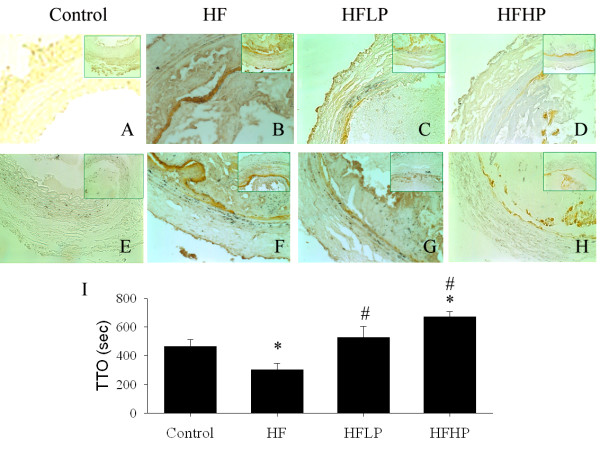
Effect of PHGG on 30% FeCl3-induced 4-HNE, ICAM-1 and TTO in the injuried carotid artery of the hamsters with HF diet. Oxidative stress indicated by 4-HNE (A-D) and ICAM-1 (E-H) immunostaining of hamster carotid arterial sections subjected to 150 sec of FeCl3-induced arterial injury. Significantly enhanced endothelial ICAM-1 (brown color in B) and and 4-HNE (brown color in F) are found in HF group subjected to FeCl3 treated carotid artery. The amplified diagram in the right corner was displayed. Carotid arterial 4-HNE and ICAM-1 expression were significantly reduced in HFLP and HFHP groups. FeCl3 induced time to occlusion (TTO) of carotid arteries obtained from control (n = 11), HF (n = 11), HFLP (n = 11) and HFHP (n = 11) groups is indicated in the I. HF shortened TTO, but was reversed by PHGG treatment. *P < 0.05 vs. control group. # P < 0.05 vs. HF group.